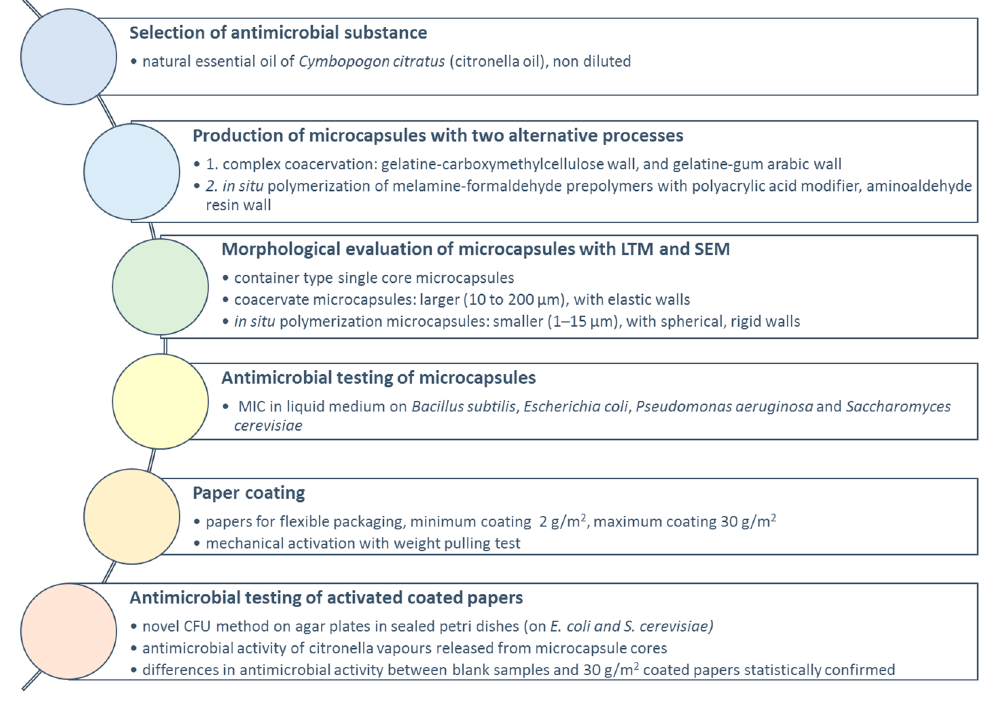
Figure 12. Outline of research flow.